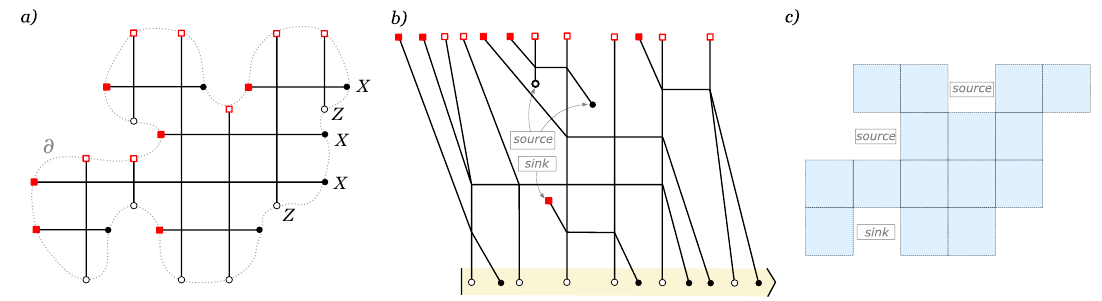
Figure 5 . Fishnet on the disk with boundary ∂ = { XZXXZ . . . } . Fields of the same type that lie on a same vertical or horizontal segment lie at the same space-time point. a) Example of a 20 -point integral at order g 15 in Fishnet CFT. b) The limit where the position of fields X, Z coincide, and the same for ¯ Z, ¯ X . We highlight the sources and sinks of magnons, corresponding to concavities of the diagram. c) Generalized Young diagram associated with the